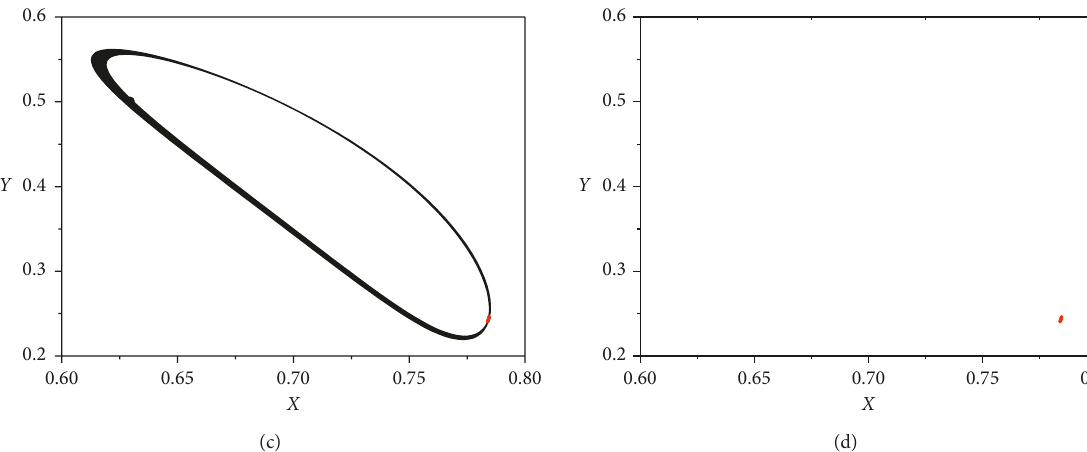
Figure 4: (a) Displacement. (b) Frequency response. (c) Rotor orbit. (d) Poincar´e map where